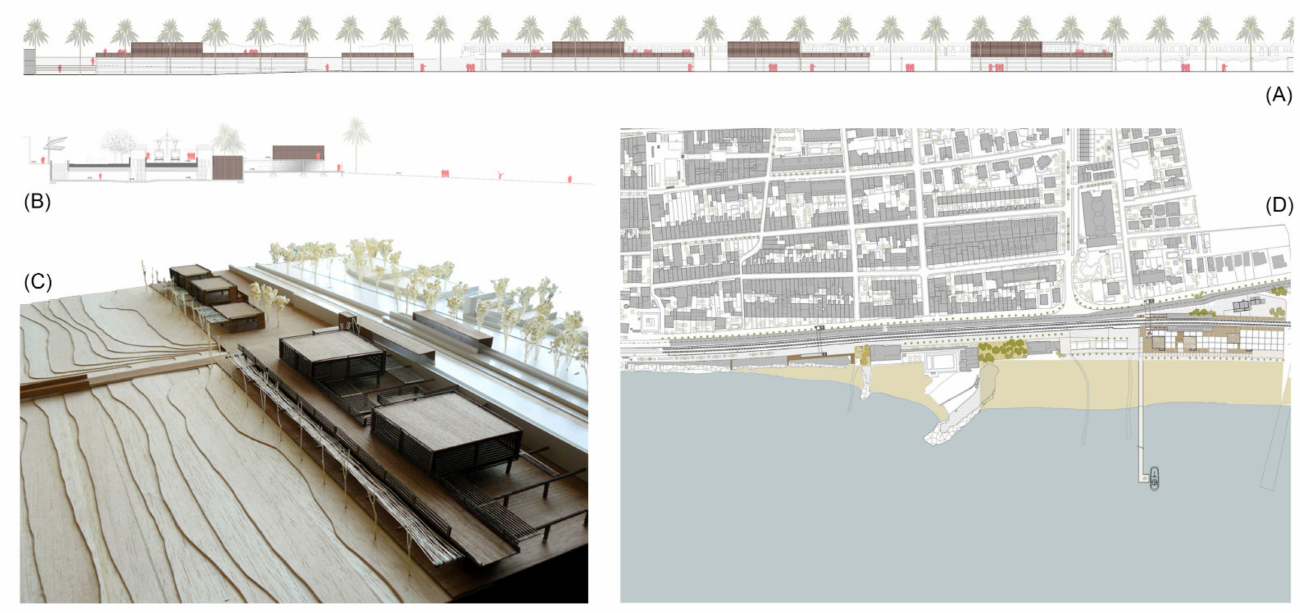
Figure 10. Urban and architectural project for the case study of a stop on the beach of Vilassar-Cabrera (Source: authors’ own). ( A ) General elevation of the maritime façade. ( B ) Transversal section through the underground passage. ( C ) Model picture of the prefabricated constructions. ( D ) General floorplan with different elements used to add order to the maritime seafront: prefabricated buildings, greenway and urban public